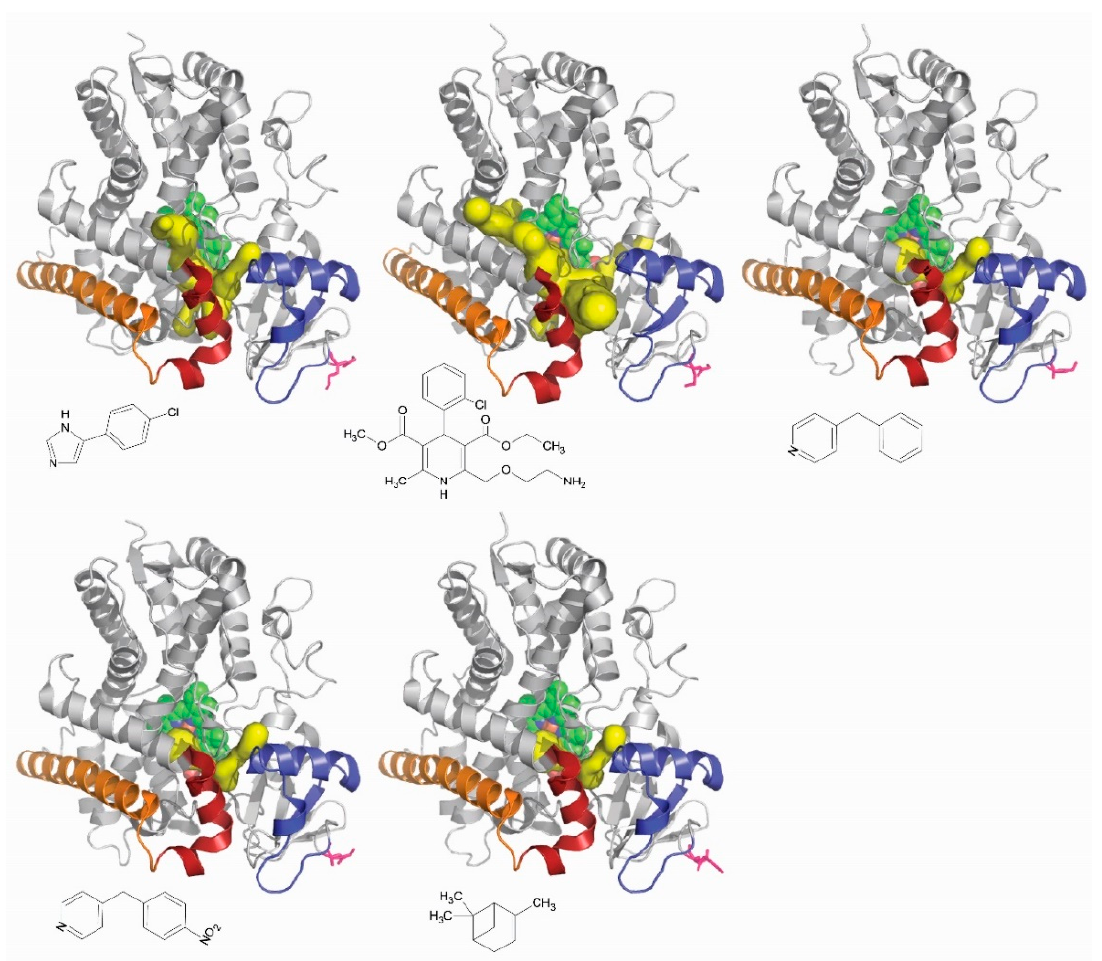
Figure 5. The crystal structures of CYP2B6 (From left to right and from the top to the bottom: 3IBD, 3UA5, 3QOA, 3QU8, and 4I91) bound to various ligands are shown with the structure elements important for cyclophosphamide affinity colored in blue, dark red, and orange. The ligand complexed is represented under each of crystal structures. The two N-terminus residues of each structure are depicted as red sticks. The heme is represented as green van der Waals spheres. Predicted access channels (depicted as yellow surfaces) were calculated using the CAVER 3.0.1 plug-in of PyMOL. For the same P450 enzyme, the combination of channels accessible changes from one ligand to the other. The role of each structure elements highlighted in cyclophosphamide affinity is explained in details in Lautier et al. [104].